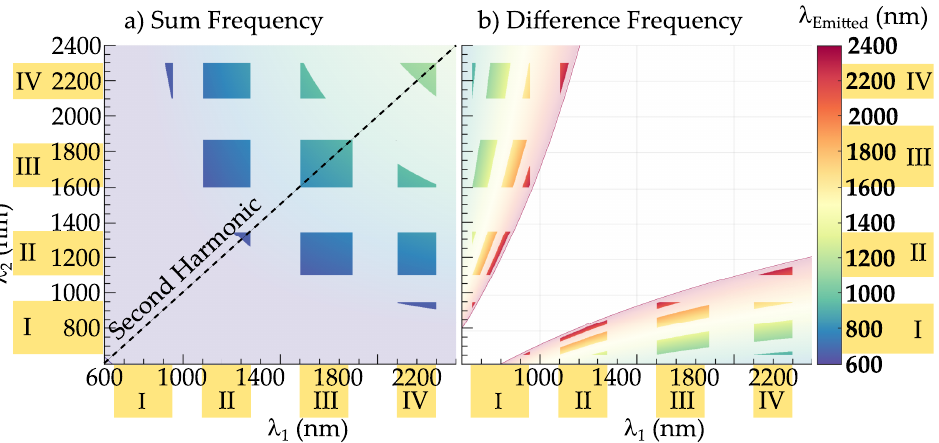
Figure 5. Simulation on the sum frequency generation ( a ) and difference frequency generation ( b ) in the wavelength range from 600 till 2400 nm, covering the biological windows NIR-I to IV, marked in yellow. The emitted wavelength can be read in the colorbar. The dashed line represents the second harmonic generation, a special case of the sum frequency generation when λ 1 = λ 2 . The areas with reduced opacity refer to all wavelength pairs of SFG/DFG that are lying outside of the biological